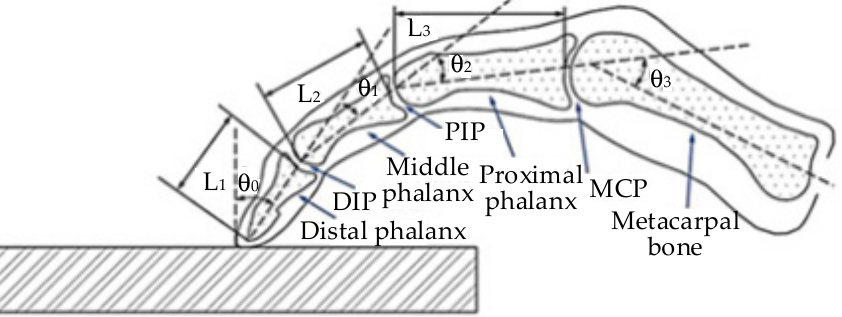
Figure 8. Finger joints and angles.